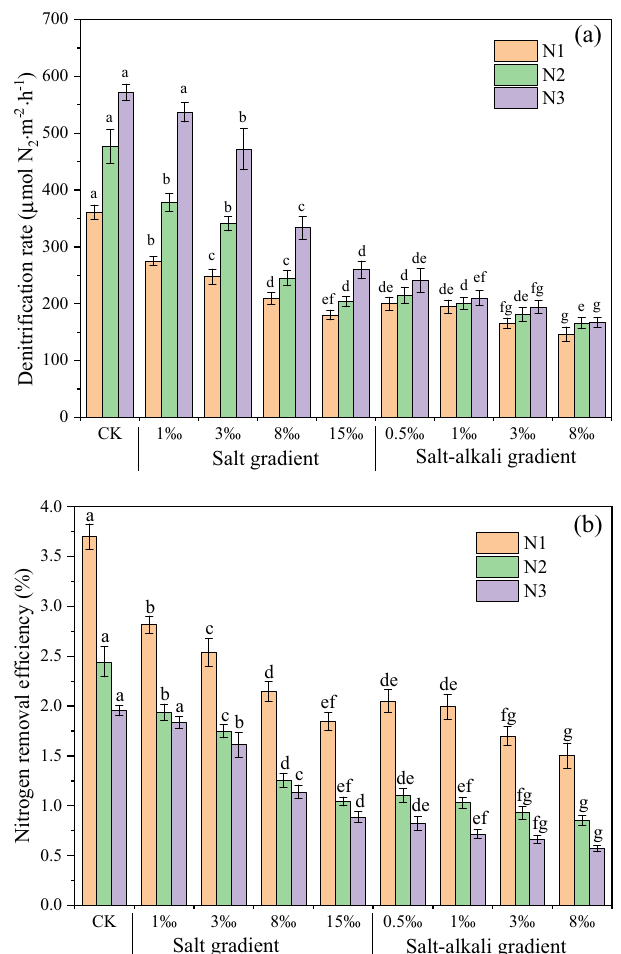
Figure 1. Denitrification rates ( a ) and nitrogen removal efficiency caused by denitrification ( b ) under various salt/salt-alkali gradients and urea levels within 24 h. The different letters above the bars indicate significant differences between the treatments within salt/salt-alkali gradients under the same urea level. Note: N1, N2, and N3 represent 0.05‰, 0.10‰ and 0.15‰ urea addition, respectively. Bars represent denitrification rates; error bars denote standard deviations of three independent repetitions (n = 3). Different letters indicate the significant differences among treatments under the same nitrogen condition (p < 0.05, one-way ANOVA followed by Duncan’s test).